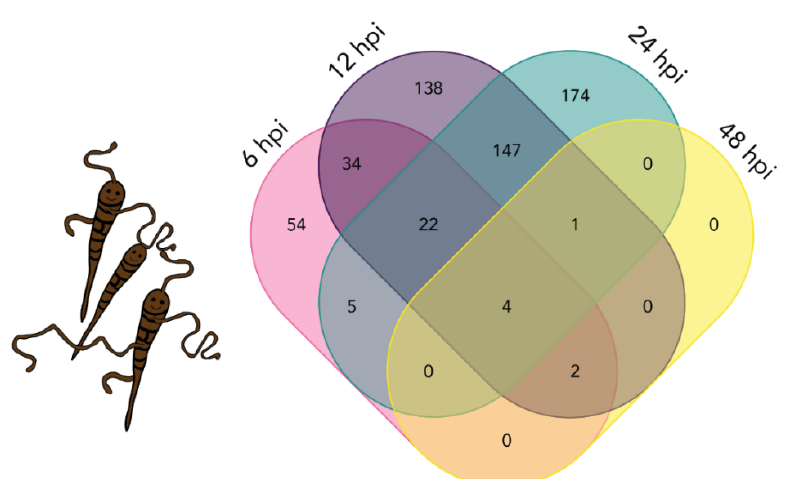
Figure 6. Venn diagram displaying overlap between the numbers of differentially expressed tran- scripts (DETs) from A. solani at different time points. Overlap between A. solani DETs at 6 hpi (pink), 12 hpi (purple), 24 hpi (green) and 48 hpi (yellow).